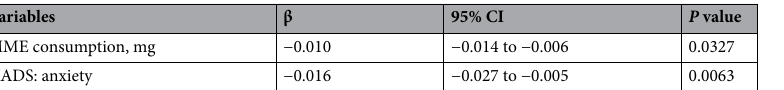
Table 3. Multivariate analysis of predictors for APSP trajectory slope. APSP Acute presurgical pain , MME morphine milligram equivalent, HADS Hospital Anxiety and Depression